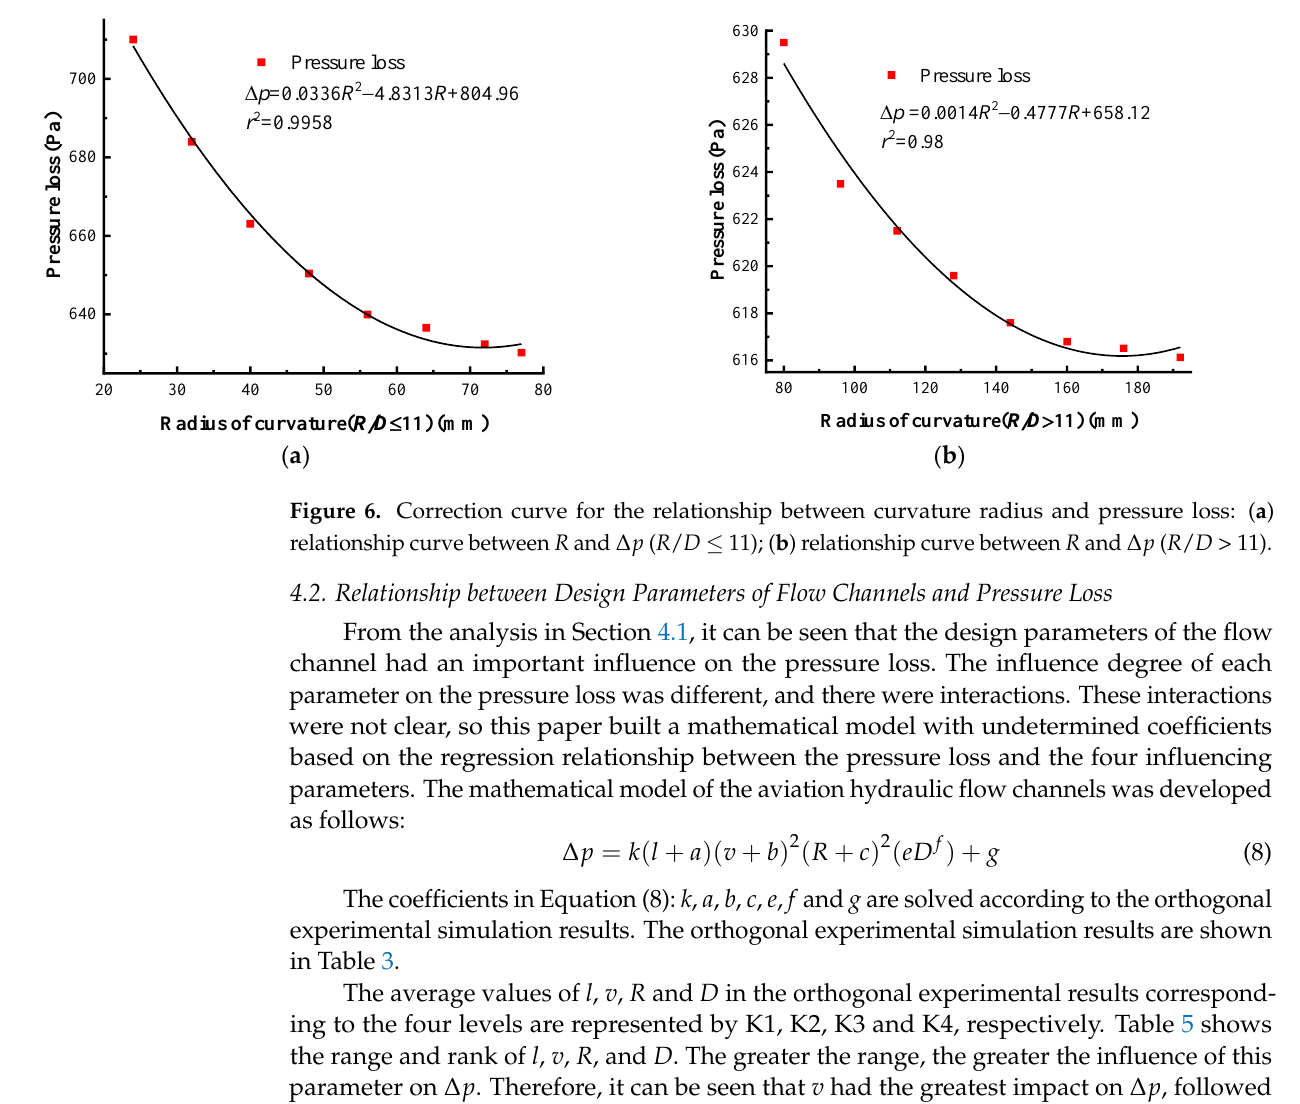
( d ) Figure 5. Relationship curve between pressure loss (  p ) and flow channel design parameters: ( a ) relationship curve between D and  p ; ( b ) relationship curve between l and  p ; ( c ) relationship curve between v and  p ; ( d ) relationship curve between R and  p . It can be seen from Equation (7) that  p was affected by the parameter R / D , so the relationship curve between  p and R could be transformed into the relationship curve between  p and R / D , as shown in Figure 6. It can be seen from Figure 6 that when R / D ≤ 11, the relationship between  p and R was a quadratic function, and the value of the regression curve r 2 was greater than 0.99; when R / D > 11, the relationship between  p